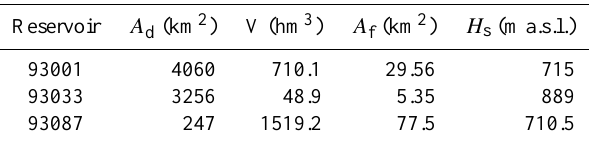
Table 1. Main variables of reservoirs: drainage area ( A d ) , volume up to the spillway crest ( V ), flooded area at the spillway crest height ( A f ) , elevation of the spillway crest ( H s )